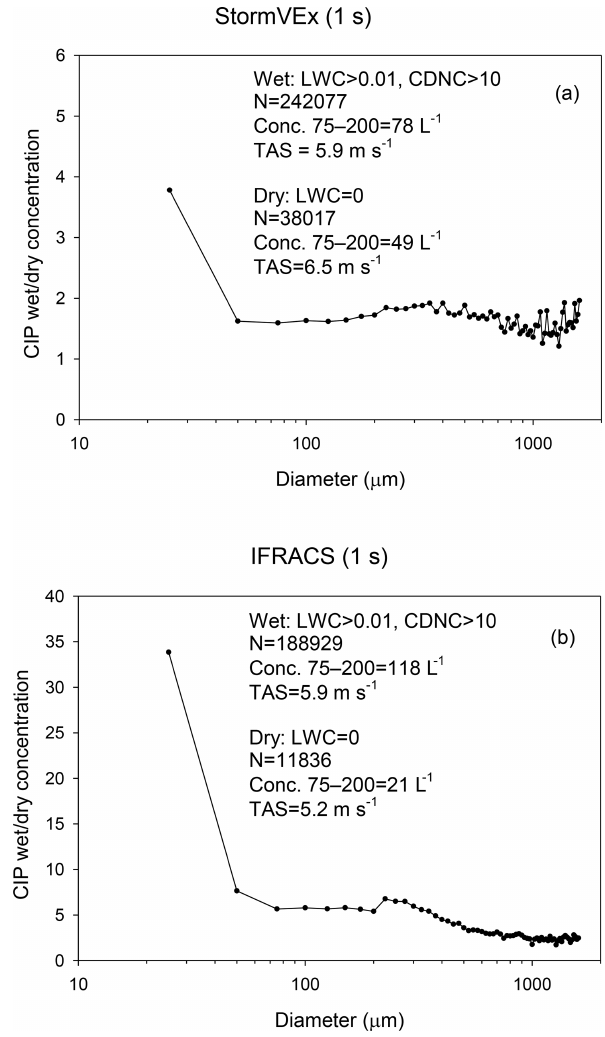
Figure 3. Ratio of average mixed-phase (LWC > 0 . 01gm − 3 , CDNC > 10cm − 3 ) wet to dry (LWC = 0) PSDs for StormVEx (a) and IFRACS (b)